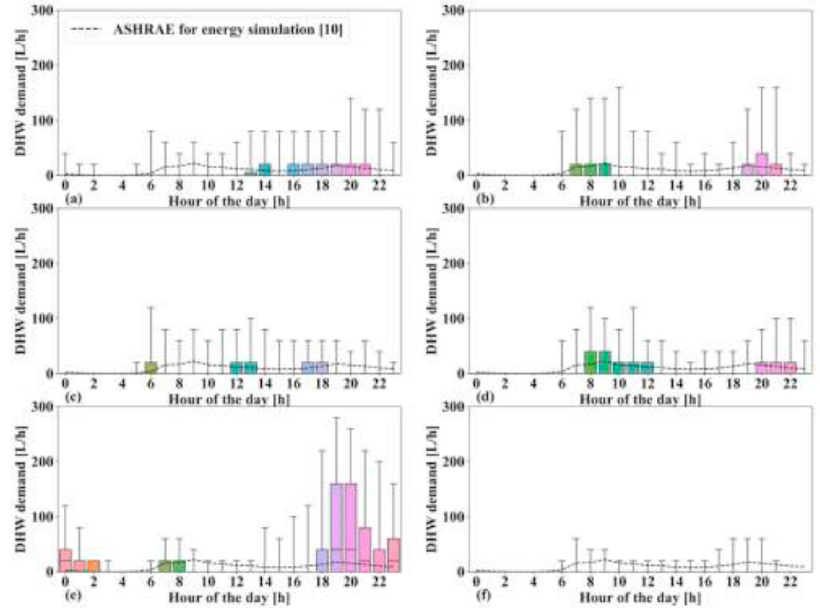
Figure 5. Average DHWC profile in 6 dwellings [18], being profiles from ( a ) a dwelling with con- sumption mainly during the evening, ( b – d ) dwellings with consumption in the morning and evening, ( e ) a high consumption dwelling and ( f ) a low consumption dwelling. Reprinted from Ref. [18], Copyright 2021, with permission from Elsevier.